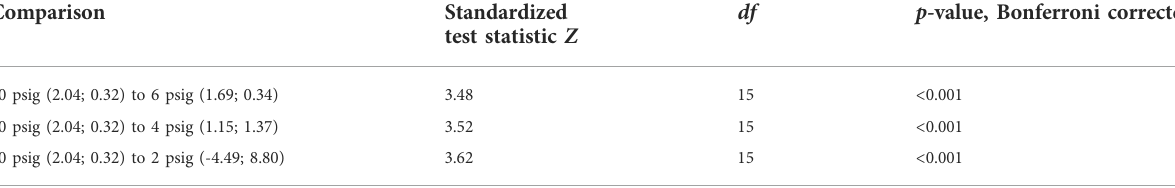
TABLE 1 Wilcoxon sign test of minimum regulator outlet pressures for different regulator inlet